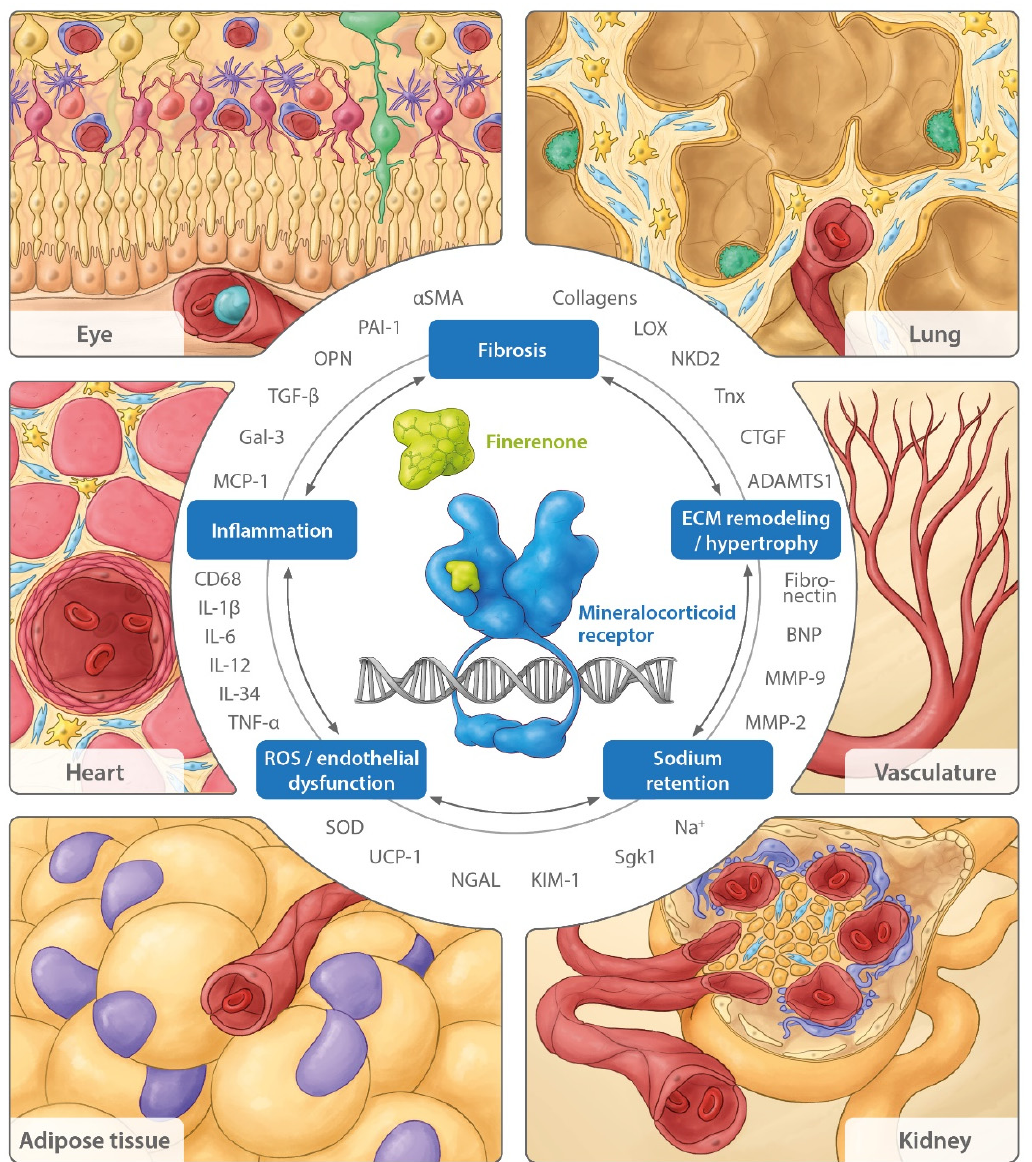
Figure 1. Components of pathophysiological MR overactivation that are counteracted by finerenone in different organs and cell types, including relevant biomarkers. Antagonism by finerenone coun- teracts the pathophysiological components of MR overactivation including sodium retention, ROS generation and endothelial dysfunction, inflammation, fibrosis, ECM remodeling and hypertrophy. Biomarkers with a modified expression induced by MR antagonism with finerenone in diverse pre- clinical disease models are depicted around the mechanistic components. Organs including critical functional units (e.g., retina in the eye, alveolus in the lung, and glomerulus in the kidney) and relevant specific cell types (e.g., fibroblasts in light blue and macrophages in yellow) with a docu- mented MR-based pathophysiology, as described in the text, are framing the view. α SMA, alpha smooth muscle actin; ADAMTS1, a disintegrin and metalloproteinase with thrombospondin type 1 motif 1; BNP, B-type natriuretic peptide; CD68, cluster of differentiation 68; CTGF, connective tissue growth factor; ECM, extracellular matrix; Gal-3, galectin-3; IL, interleukin; KIM-1, kidney injury molecule 1; LOX, lysyl oxidase; MCP-1, monocyte chemoattractant protein-1; MMP, matrix metal- loproteinase; NGAL, neutrophil gelatinase-associated lipocalin; NKD2, naked cuticle homolog 2; OPN, osteopontin; PAI-1, plasminogen activator inhibitor-1; ROS, reactive oxygen species; Sgk1, serum- and glucocorticoid-regulated kinase 1; SOD, superoxide dismutase; TGF- β , transforming growth factor- β ; TNF- α , tumor necrosis factor- α ; Tnx, tenascin-X; UCP-1, uncoupling protein-1.